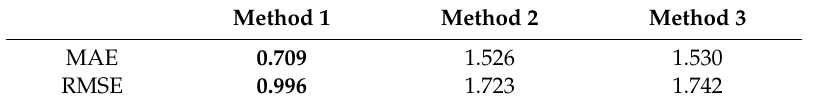
Table 8. Performance comparisons among di ff erent methods of generating user